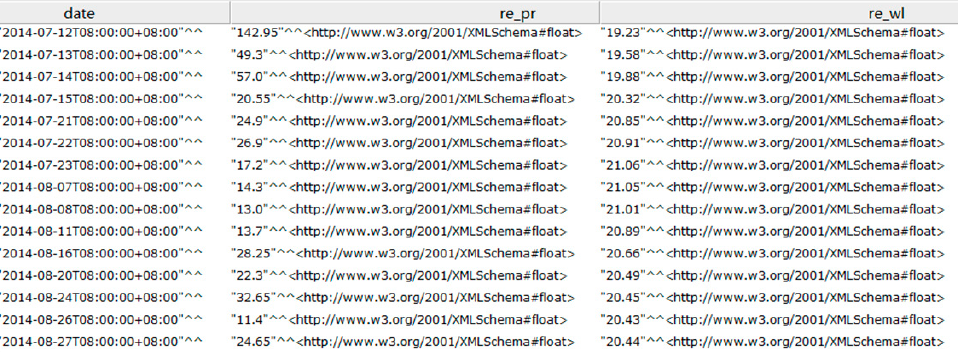
Figure 6. The result dates when the precipitation > 10 mm and the water level > 19 m at Liangzi Lake.